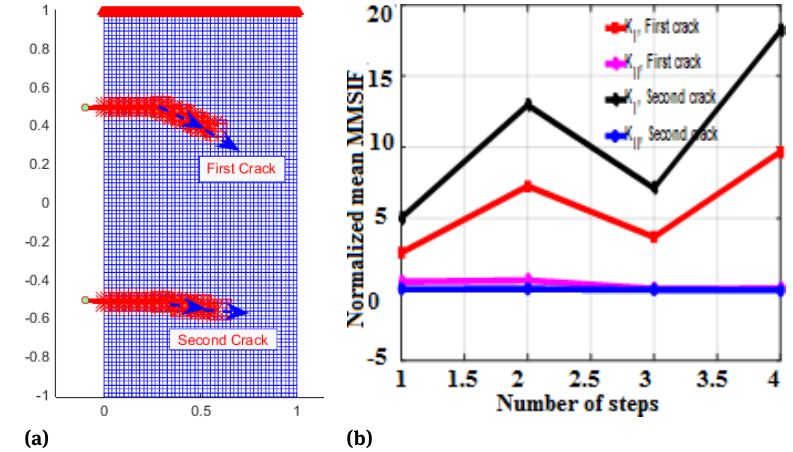
Figure 5: (a) Crack propagation path for double edge crack plate under shear loading and (b) Normalized